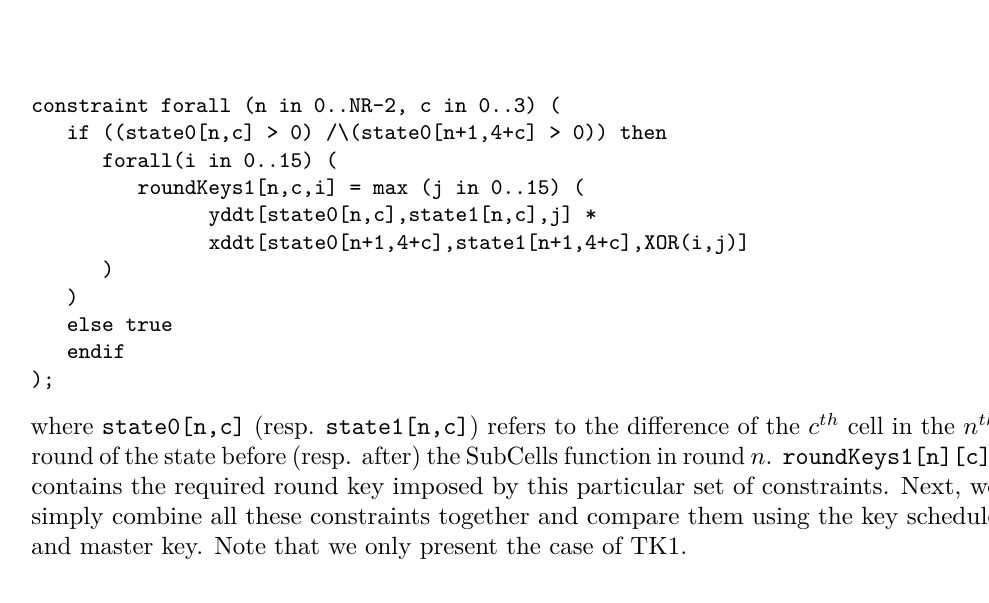
Mind Your Path: On (Key) Dependencies in Differential